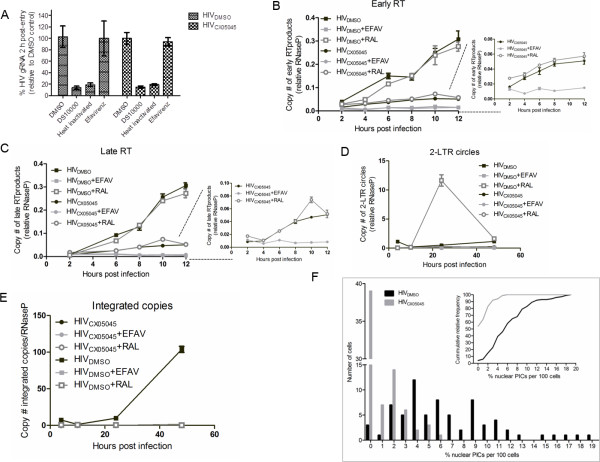
Systematic evaluation of the multiple effects of LEDGINs on HIV-1 replication. (A-E) (RT)-qPCR analyses for gRNA and viral DNA species evaluating early replication events (entry to integration) are shown. (A) HIVCX05045 enters cells as efficient as the control (HIVDMSO) virus as measured by RT-qPCR analysis of gRNA isolated 2 h after synchronized infection of MT-4 cells. As expected, addition of DS10000, but not efavirenz, inhibits entry of both HIVDMSO and HIVCX05045. Heat-inactivated virus preparation was used as negative control. Mean values ± standard deviation from three independent experiments are shown. (B, C) qPCR analysis for early and late RT product kinetics in MT-4 cells infected with HIVDMSO or HIVCX05045 in the presence or absence of efavirenz (EFAV) or raltegravir (RAL) added during infection as RT and integration inhibitor controls. There is a five-fold less RT products in cells infected with HIVCX05045 compared to HIVDMSO and efavirenz blocked the RT activity of both viruses. (D, E) 2-LTR circle and integrated copies kinetics are shown. HIVDMSO has normal nuclear import as well as integration which are evidenced by the accumulation of 2-LTR circles in cells treated with raltegravir. In stark contrast to HIVDMSO, the PICs of HIVCX05045 did not translocate into the nucleus as shown by background integrants. This result was further supported by the lack of the accumulation of 2-LTR circles when cells were treated with raltegravir (HIVCX05045+RAL). Mean values ± standard deviations for triplicate measurements. (F) Analysis of HIV preintegration complex (PIC) nuclear import. Percentage of nuclear versus total PICs in cells infected with HIVCX05045 (gray bars, n = 72) or HIVDMSO (black bars, n = 71) is shown. More than 50% of cells infected with HIVCX05045 did not contain any fluorescently labeled PIC in the nucleus. In contrast, 2-7% of fluorescently labeled PICs were detected in the nucleus of more than 50% of cells infected with HIVDMSO. In the inset, the cumulative probability of nuclear PICs is plotted for HIVCX05045 (gray) and HIVDMSO (black). The empirical distribution function was computed using the Kolmogorov-Smirnov test, p < 0.0001).